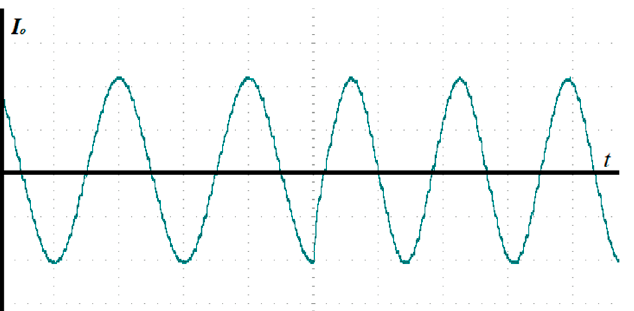
Figure 16. Dynamic response when the frequency of output reference current changes suddenly, I o (1 A/div).